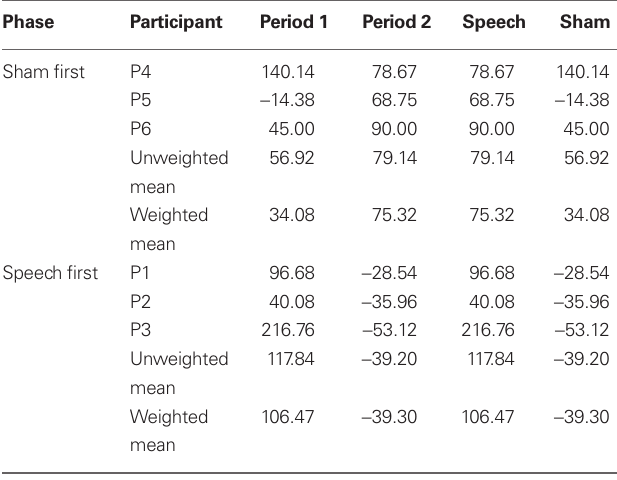
Table 5 | Duration delta scores presented by Phase and for each participant